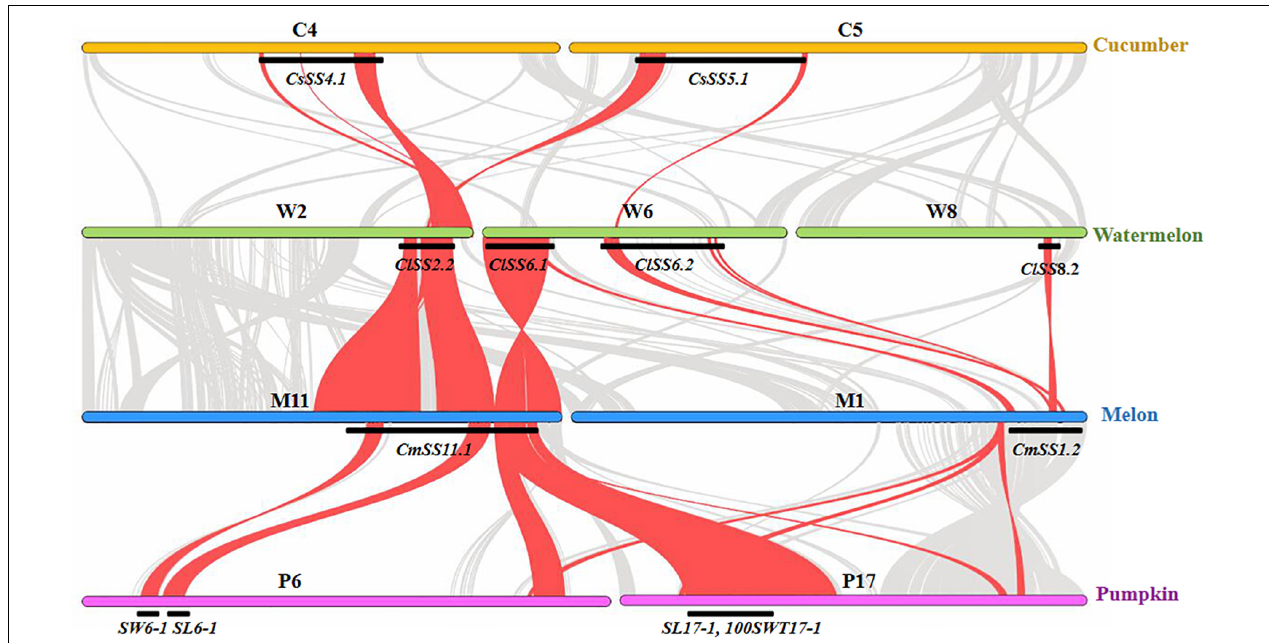
FIGURE 5 | Syntenic relationships of watermelon chromosomes W2, W6, and W8 harboring major-effect consensus SS QTL with cucumber, melon and pumpkin chromosomes. The inference is based on watermelon “97103 V2.0,” cucumber “Gy14 V2.0,” melon “DHL92 V3.6.1,” and pumpkin “Rimu” draft genomes.